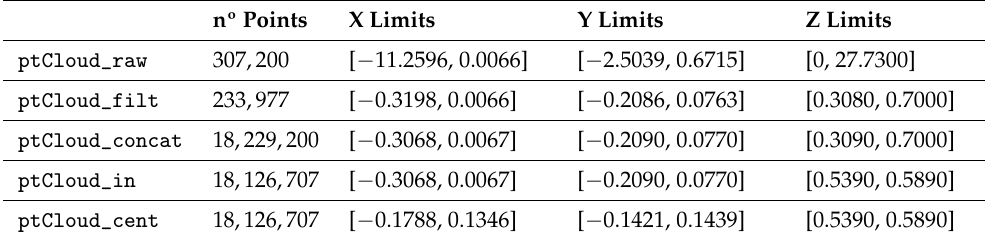
Figure 14. Methodology steps for the case of D415— water full . ( a ) ptCloud_raw . ( b ) ptCloud_filt . ( c ) ptCloud_concat . ( d ) ptCloud_in . ( e ) ptCloud_cent . ( f ) Estimated plane and orthogonal distances. Positive orthogonal distances are colored in red and negative in green. For visualization purposes, ( f ) contains a sub-sample of the estimated orthogonal distances. That is, the distances were displayed with a ratio of 1 regarding the total number of distances. 1000 Table 2. The structure of the point clouds at different processing stages for the case of D415— water